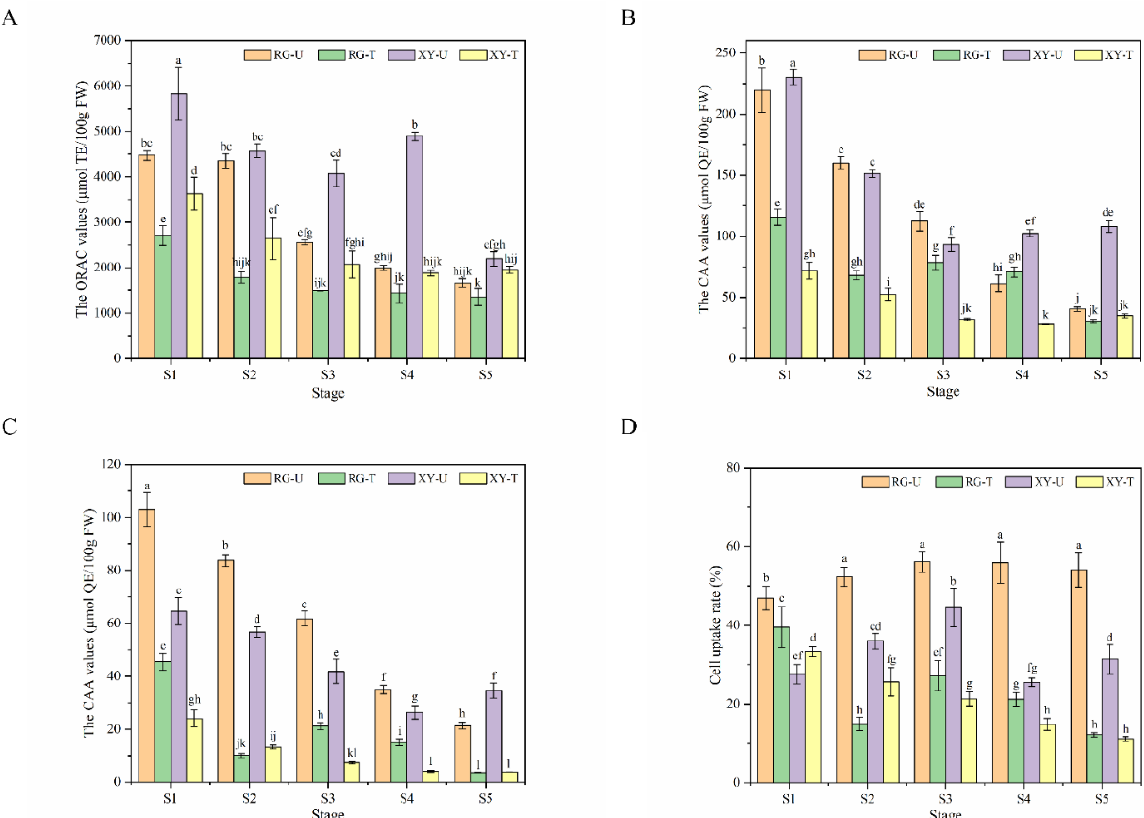
Figure 2. Antioxidant activities of grape berries in ORAC values and CAA values during the five developmental stages in Urumqi and Turpan. ( A ) ORAC values; ( B ) CAA values under no PBS wash protocol; ( C ) CAA values under the PBS wash protocol; ( D ) cell uptake rate. Bars with different letters differ significantly at p < 0.05. RG − U, Urumqi ‘Red Globe’ grapes; RG − T, Turpan ‘Red Globe’ grapes; XY − U, Urumqi ‘Xin Yin’ grapes; XY − T, Turpan ‘Xin Yu’ grapes.